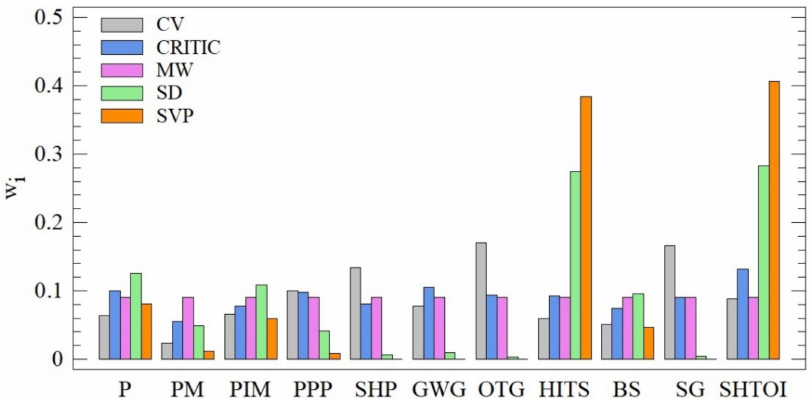
Figure 5. Comparison of the assigned weights based on the individual methods (CV, CRITIC, MW, SD and